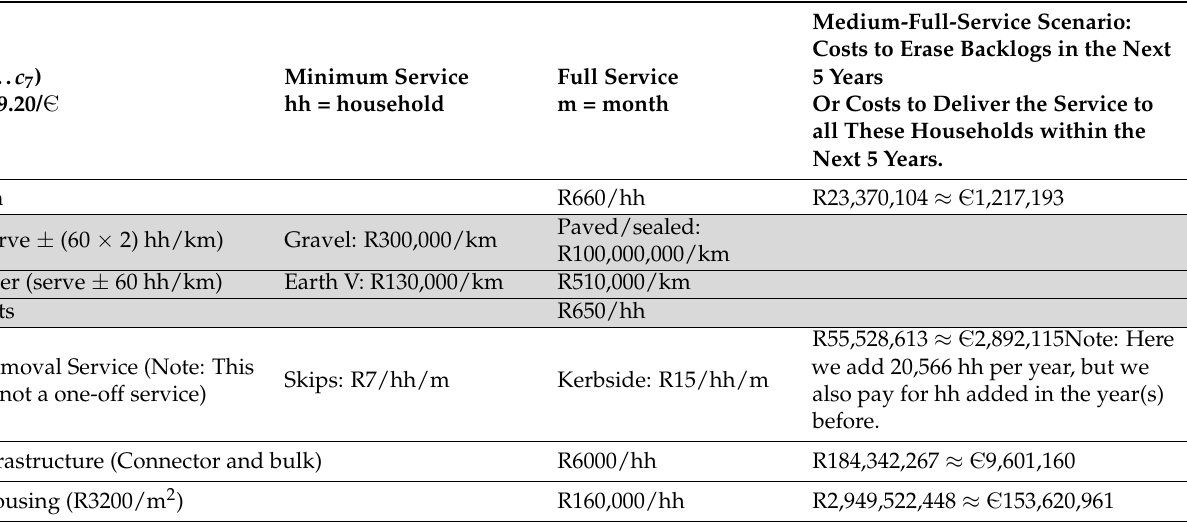
Table 8. Unit costs for basic level services (Source: Own construction from The Municipal